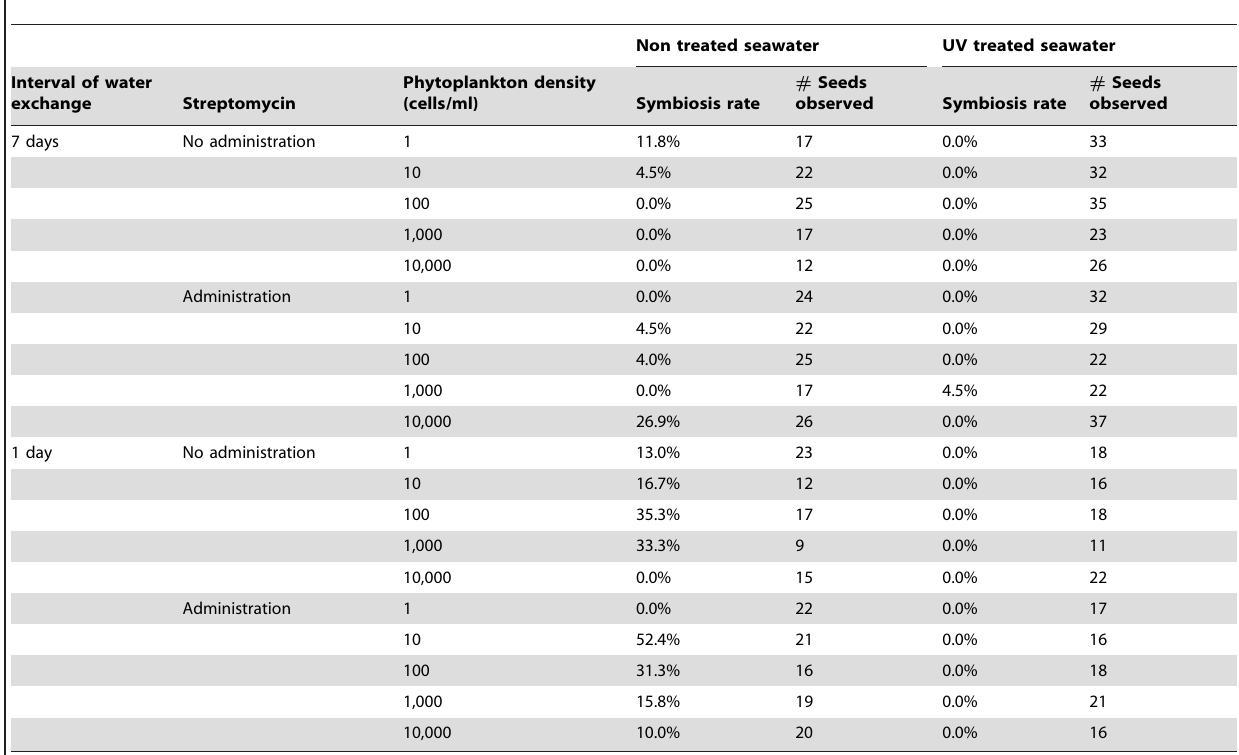
Showing what percentage of the seeds established a symbiotic relationship with Symbiodinium after the seeds had been reared in non treated and UV treated seawater, provided with food phytoplankton and streptomycin. groups, each of which then was filtered through 1 of 7 filters (0.2,